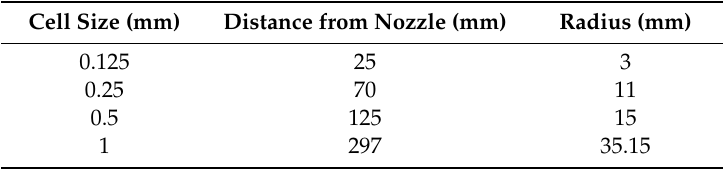
Table 1. Mesh refinements with dimensions related to the nozzle